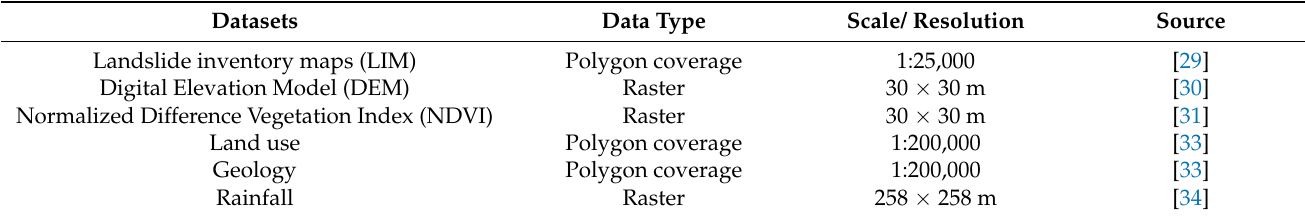
Table 1. Summary of